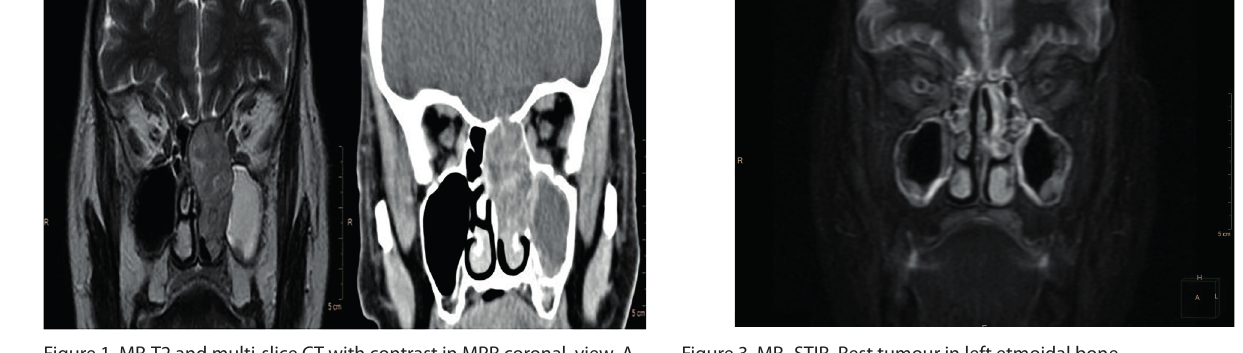
Figure 1. MR-T2 and multi-slice CT with contrast in MPR coronal view. A Figure 3. MR- STIR. Rest tumour in left etmoidal